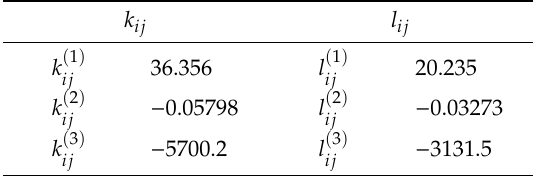
Table 2. Interaction parameters for carbon dioxide (1) + acetone (2)